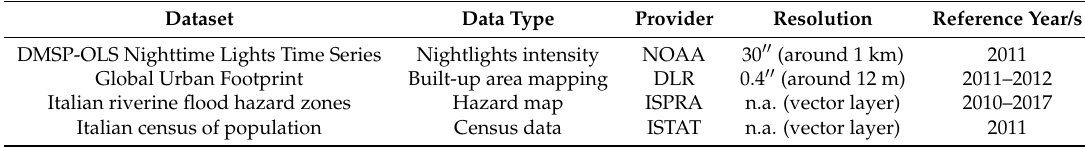
Table 1. Input and validation data used to test the proposed